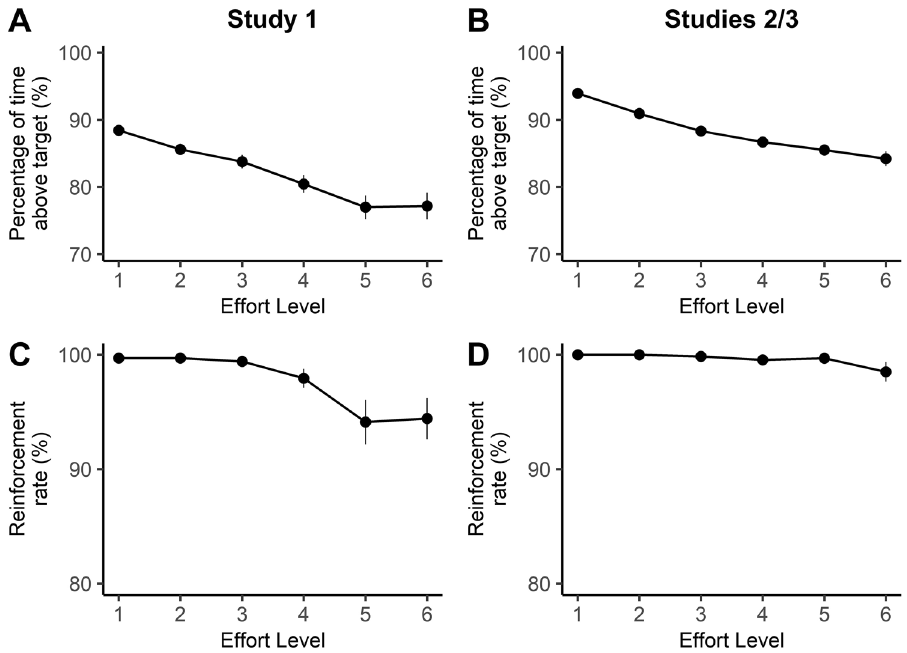
Figure 2. Data from the reinforcement phase for ( A,C ) Study 1, and ( B,D ) Studies 2/3. ( A,B ) In all studies, the percentage of time that individuals maintained their contraction above the target effort level decreased with increasing effort. ( C,D ) This translated to lower reinforcement rates at the higher levels of effort for all studies, although this was more pronounced for ( C ) Study 1 than ( D ) Studies 2/3. Error bars indicate ± 1 standard error